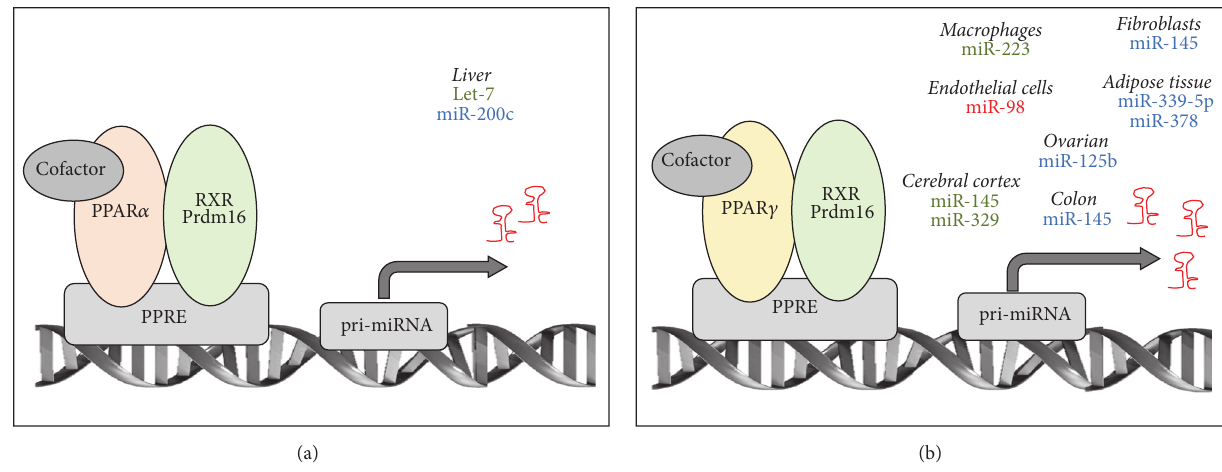
Figure 4: miRNAs expression induced by PPAR 𝛼 and PPAR 𝛾 . Induction of miRNAs by PPAR 𝛼 (Panel (a)) and PPAR 𝛾 (Panel (b)) binding to PPRE in pri-miRNA promoters in specific tissues is indicated. miRNAs identified in human studies are in blue, those identified in mouse/rat studies are in green, and those identified in both human and rodents studies are in red. RXR: Retinoid-X-Receptor; Prdm16: PR domain- containing 16; PPRE: peroxisome proliferator response element